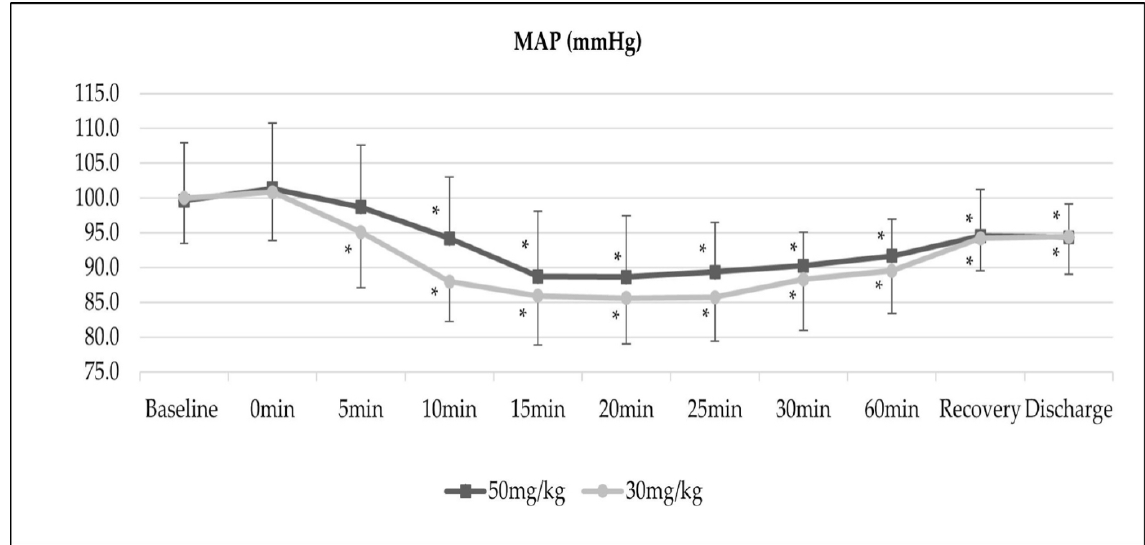
Figure 1 demonstrates the trend of MAP of both groups. The MAP trend was signif- icantly lower in Group B compared to Group A ( p -value < 0.01). A significant decrease in MAP between baseline at the 10th, 15th, 20th, 25th, 30th and 60th min, at recovery and during discharge was observed in both groups.